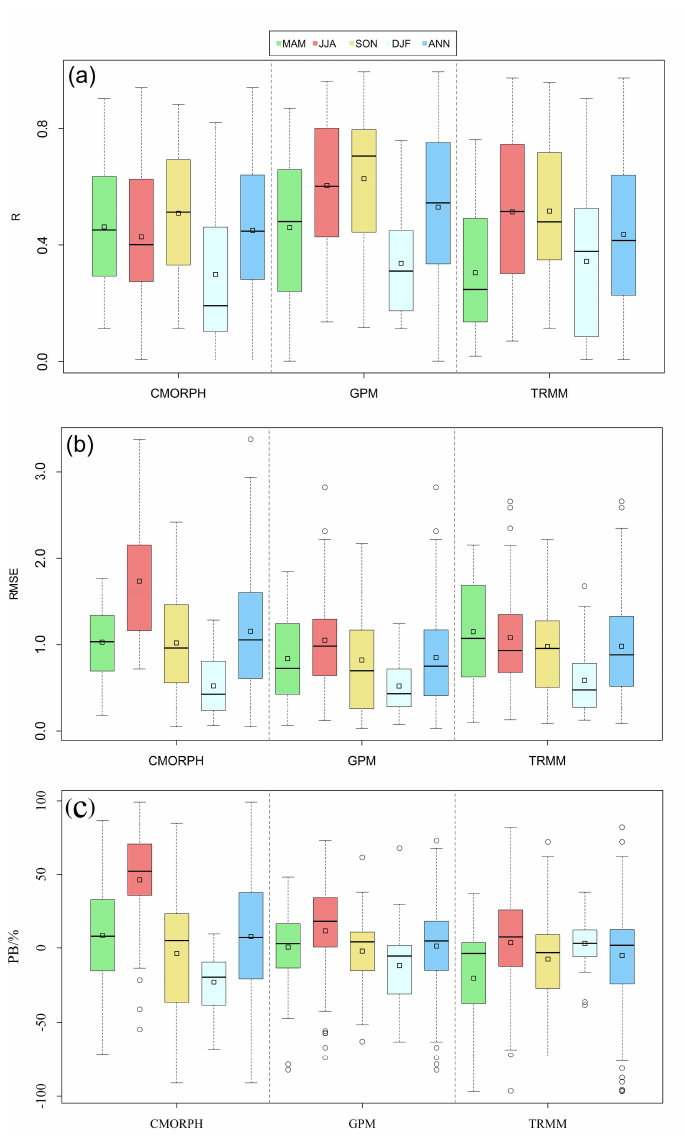
Figure 2. Results of different accuracy estimators for each satellite-based product in different seasons. The statistical metrics are ( a ) Pearson linear correlation coefficient, ( b ) root-mean-square error, and ( c ) relative bias. The solid black line represents the median value, the square represents the average value; from top to bottom, the four horizontal lines are the upper edge line, the upper quartile, the lower quartile, and the lower edge, respectively, and the empty black dots represent